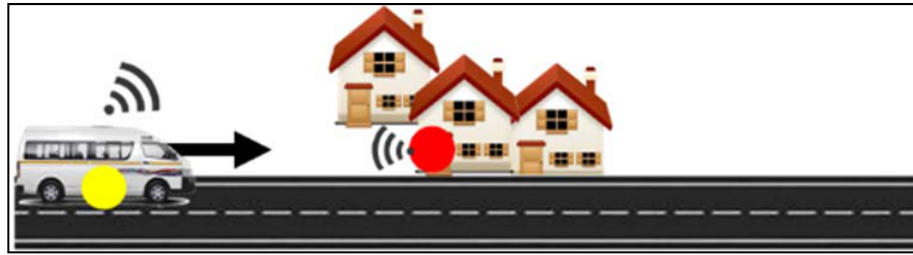
Figure 19. Experimental Setup.